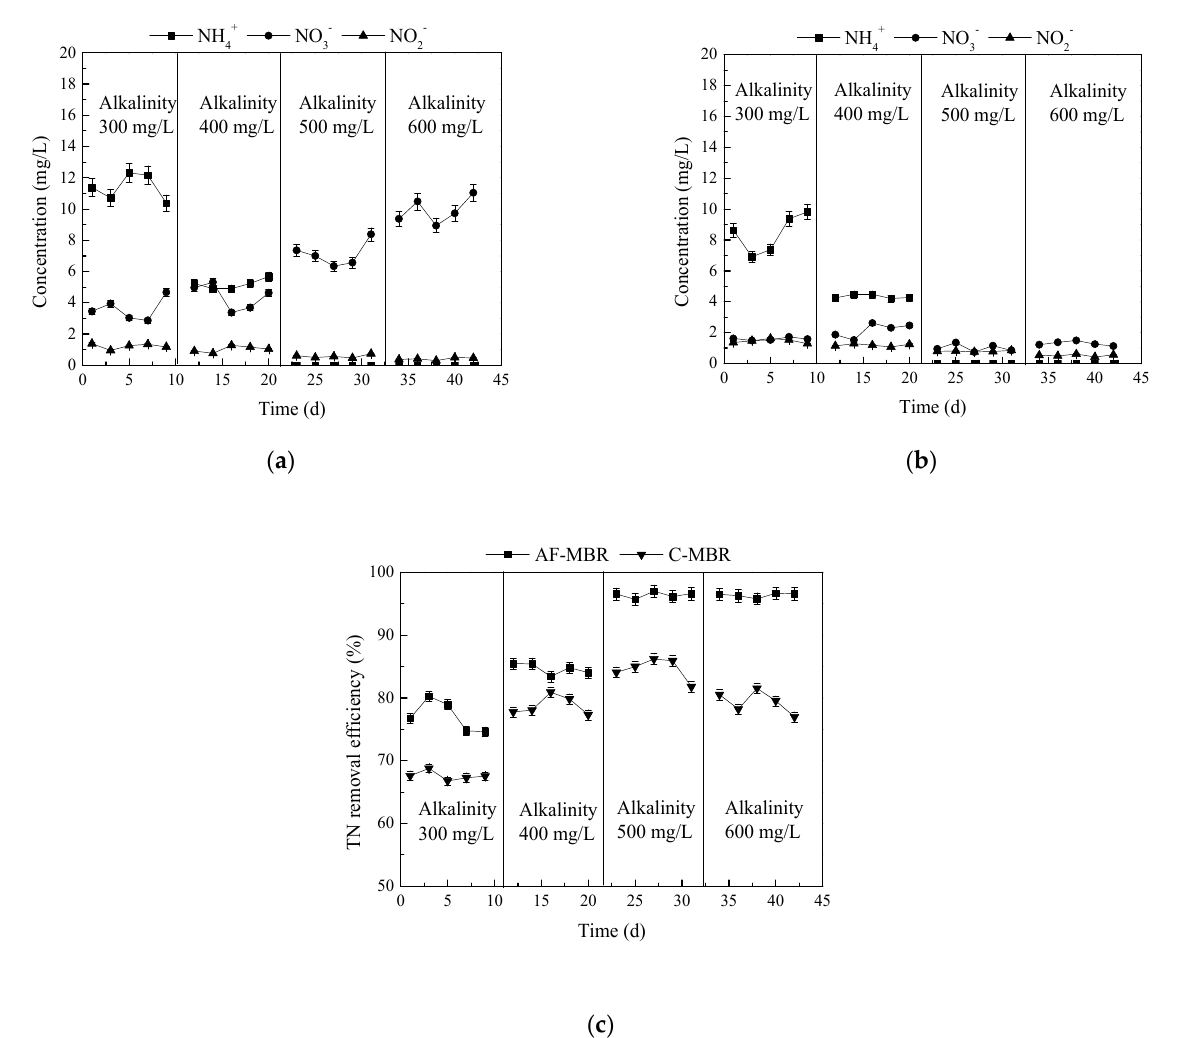
Figure 7. Effect of different influent alkalinity values on nitrogen treatment. ( a ) TN removal efficiency; ( b ) changes of NH 4+ -N, NO 2 − -N, and NO 3 − -N concentrations in AF-MBR; ( c ) changes of NH 4+ -N, NO 2 − -N, and NO 3 − -N concentrations in